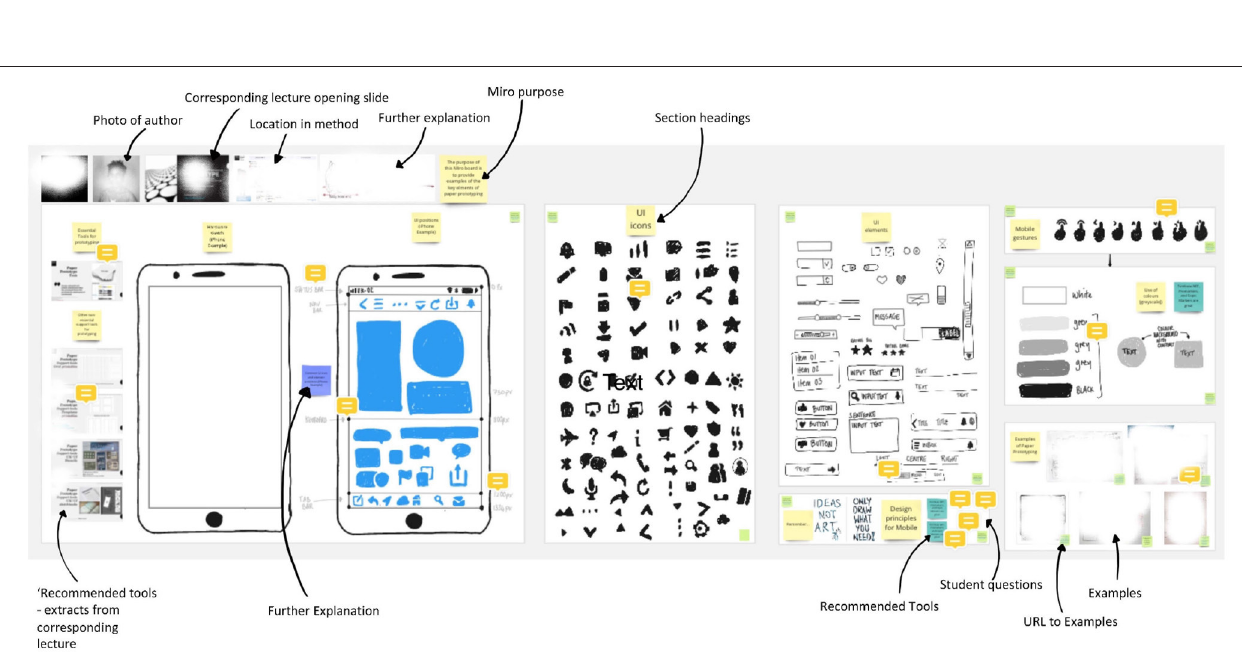
Frontiers in Computer Science |